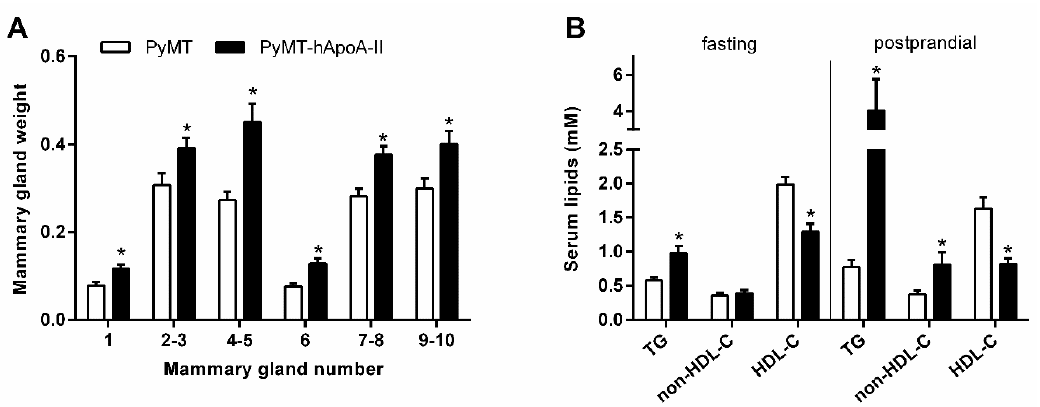
Figure 1. E ff ects of human apolipoprotein A-II (hApoA-II) overexpression on tumor development in polyoma middle T (PyMT) mice. PyMT mice were backcrossed with hApoA-II transgenic (TG) mice on a C57BL / 6 background. The mice were maintained on a regular chow diet until 19 weeks of age, when they were euthanized, and the mammary glands were excised and weighed. Serum lipids were determined after an overnight fasting period and 3 h after a 0.15 mL dose of olive oil by oral gavage. A) Mammary gland weight. B) Serum lipid levels in fasting and postprandial conditions (TG = triglycerides, and HDL-C = high-density lipoprotein cholesterol). Values shown represent the mean ± SEM. A t -test was performed to determine the statistical significance between groups. * p < 0.05 vs. PyMT